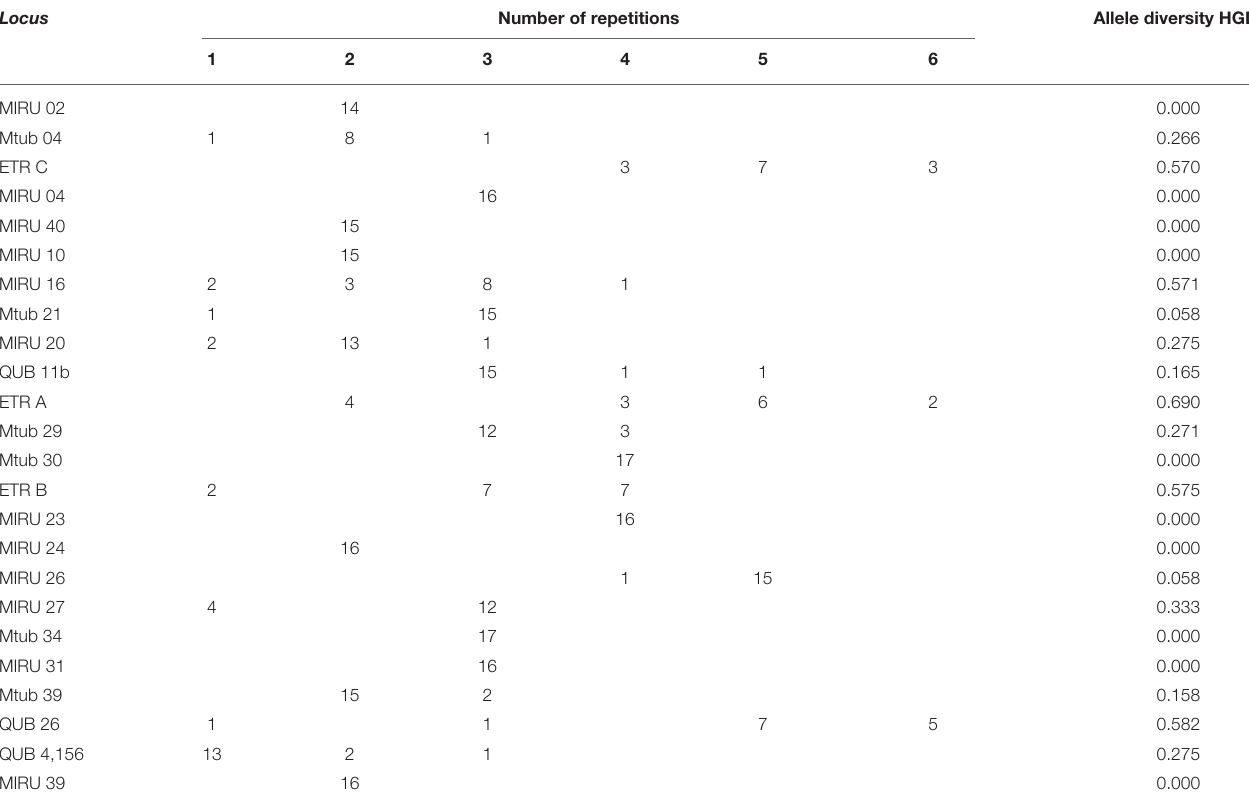
TABLE 2 | Distribution and allele diversity (HGDI) of the 24- loci MIRU-VNTR. Locus Number of